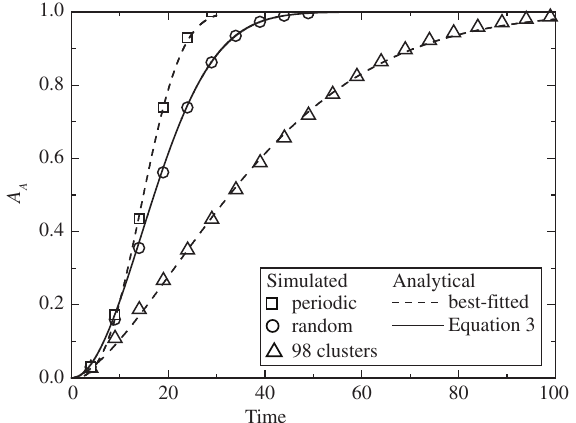
Figure 7. Interfacial area length between recrystallized grains and matrix, L , against area fraction, simulated by CA. Simulation data are force fitted A by Equation 5, allowing N to A